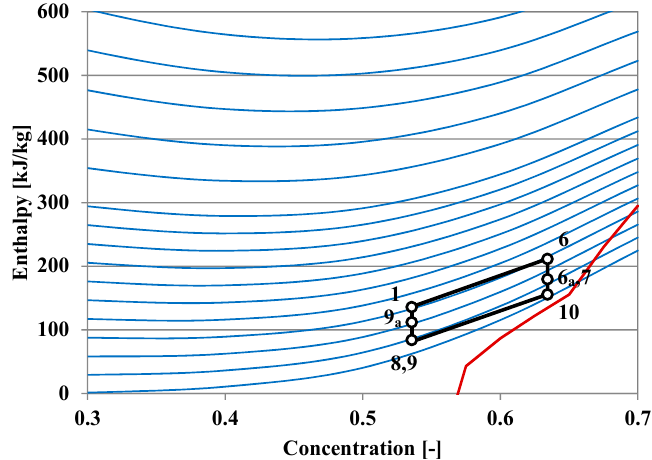
Figure 5. The working cycle of the main refrigerating circuit.